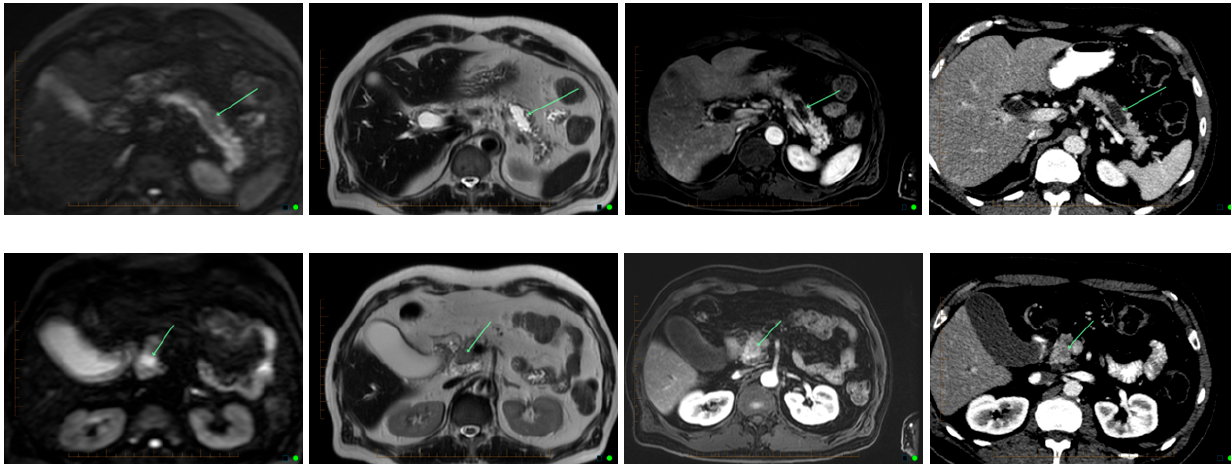
Figure 1. Transformation in IPNM on MRI and CT. From left to right- Diffusion weighted imaging, T2, post contrast T1 and CT images in the same patient. Top row shows a simple cystic lesion consistent with a side branch IPMN, showing no malignant features. Bottom row shows a cystic lesion displaying solid enhancing components with restricted diffusion, consistent with malignant degeneration within an IMPN. Arrows indicate cystic component with no cancer (top), and with cancer (bottom).